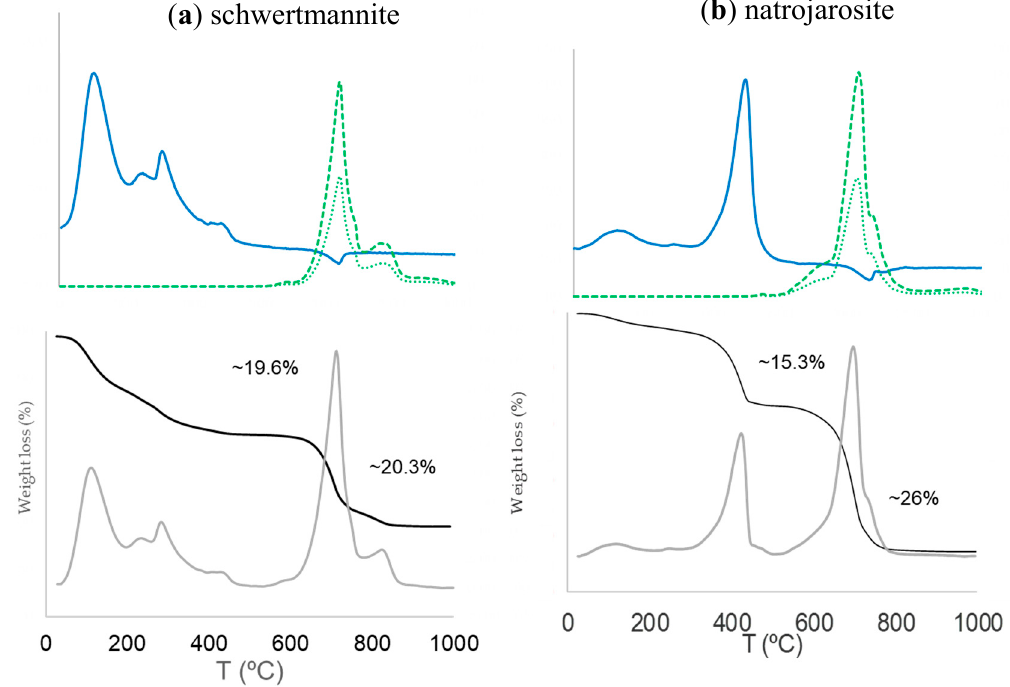
Figure 4. TG (black), DTG (grey), H 2 O (blue), SO (green dotted line) and SO 2 (green dashed line) curves from representative samples of schwertmannite ( a ) and natrojarosite ( b ) obtained at the end of